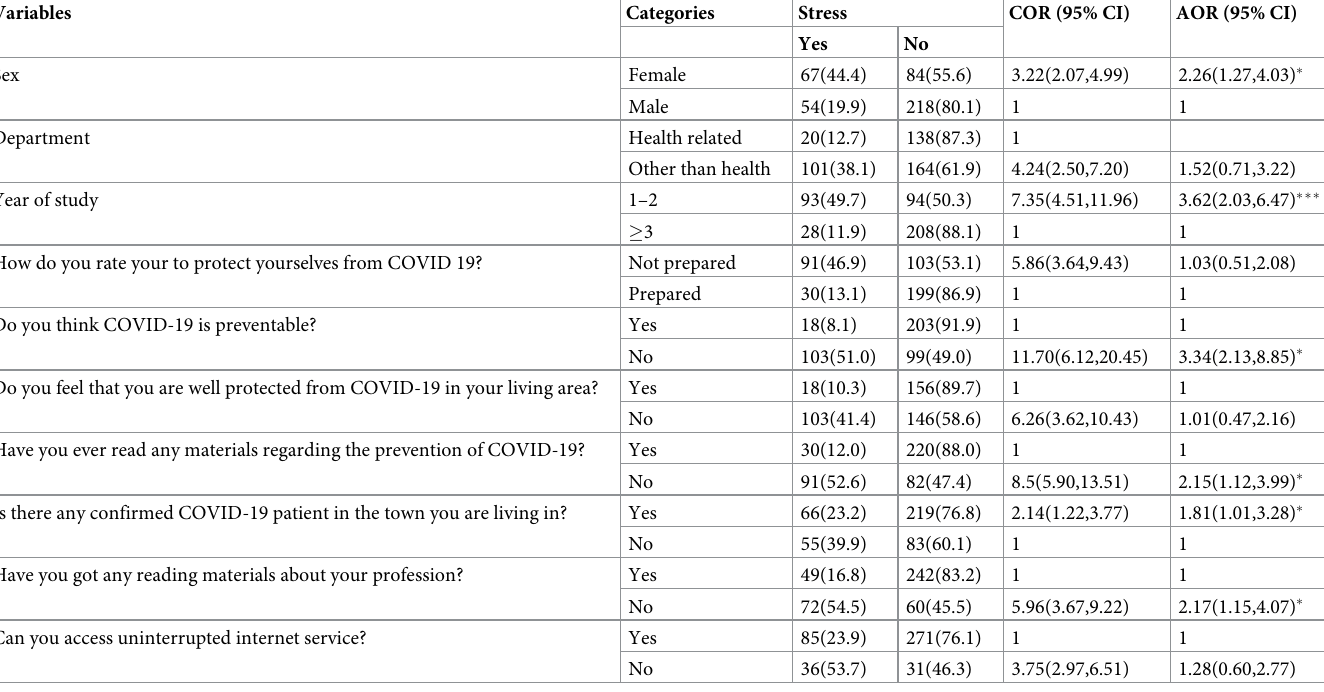
Table 5. Factors associated with stress among Ethiopian University students during the early phase of COVID-19 pandemic, 2020 (N =